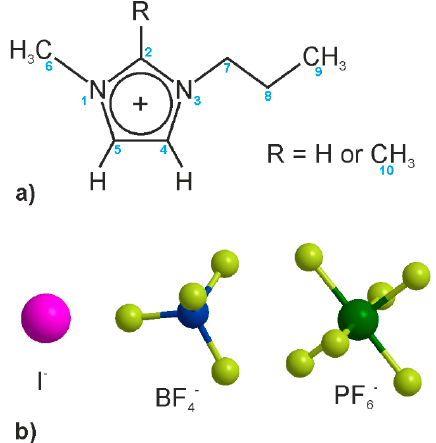
Figure 1. Chemical structure of ( a ) cations and ( b ) anions. The blue numbers in ( a ) indicate the atom numbering used in the